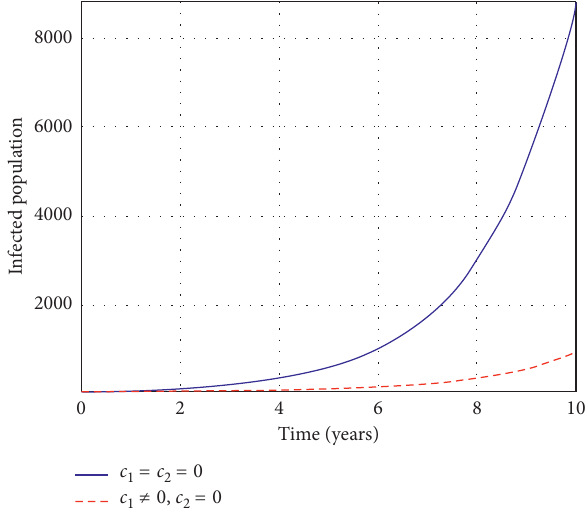
Figure 10: A graph showing the effectiveness of educational in the infected population. Figure 12: A graph showing the effectiveness of control measure c 2 campaign as the only control measure c 1 only in the infected